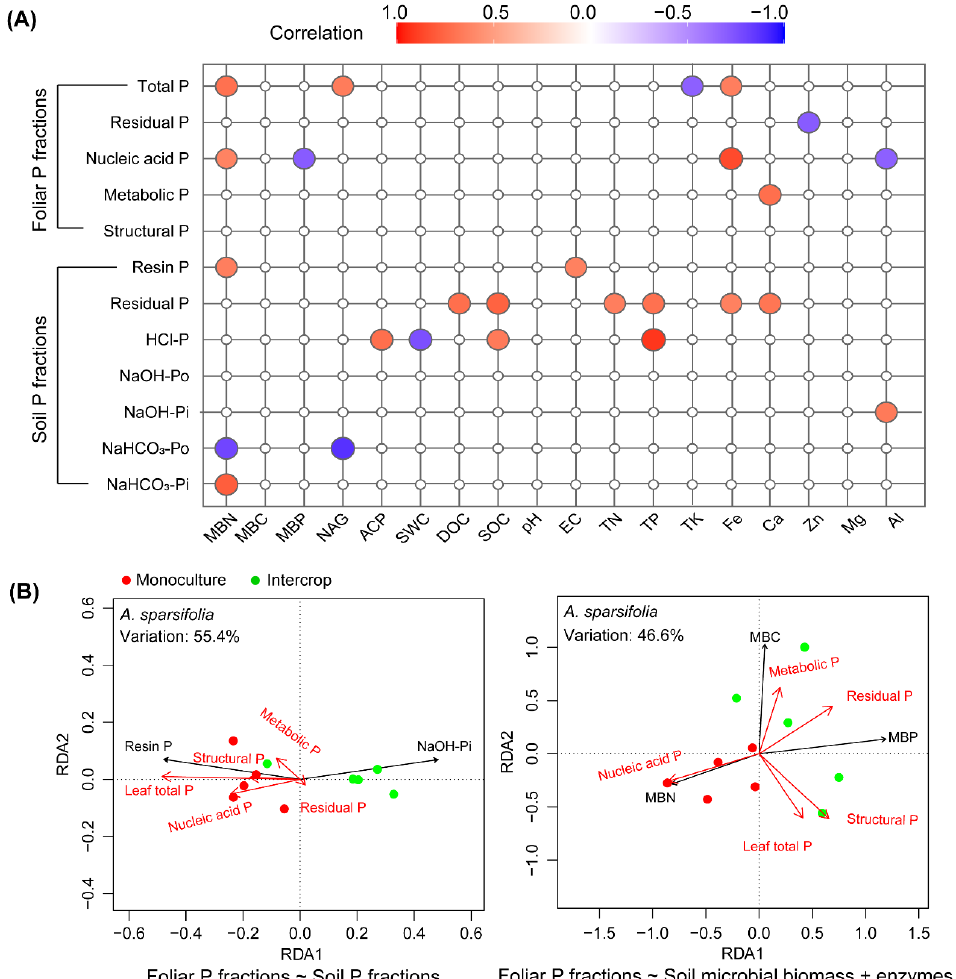
Figure 8. Relationships between foliar P and soil P fractions and environmental factors in the A. sparsifolia monoculture and its intercropped plots. Subplot ( A ) shows the Pearson’s correlation between foliar P and soil P fractions and soil properties, and only significant correlations, either positive (red circles) or negative (blue circles) ( p -value < 0.05) are displayed. Subplot ( B ) shows redundancy analysis (RDA) of the relationship between foliar P fractions and soil P fractions (left), and soil microbial biomass and soil enzymes (right); RDA plots show only the factor closely related to foliar P fractions (screened using the forward selection model with 999 permutations performed using the vegan package in R).